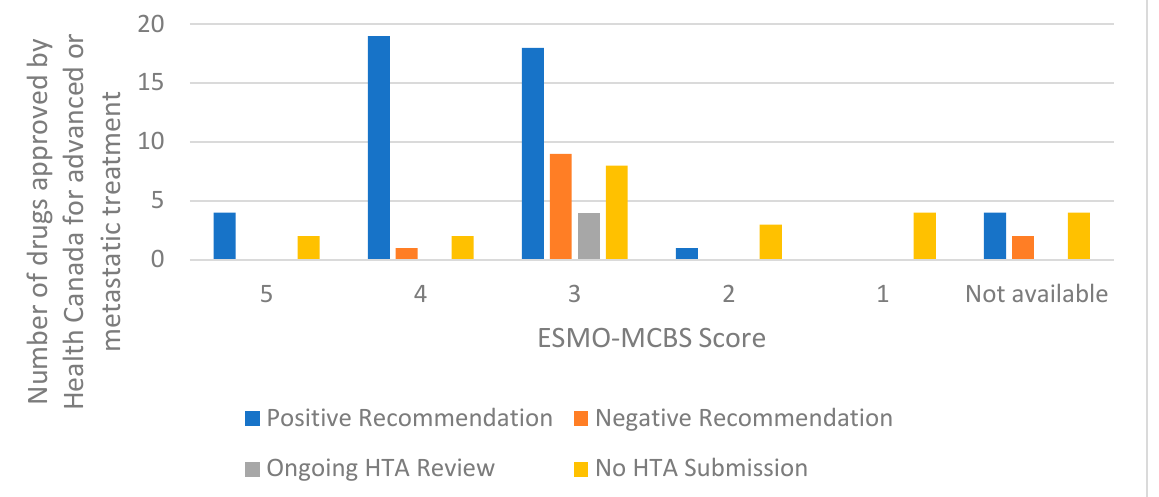
Figure 8. HTA recommendation or status based on the ESMO-MCBS score for drugs in the analysis for non-curative treatment. Abbreviations: HTA, health technology assessment; ESMO-MCBS, European Society of Medical Oncology Magnitude of Clinical Benefit Scale.